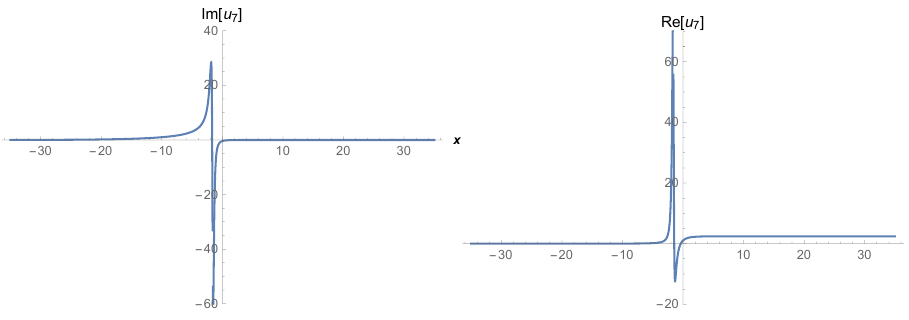
Figure 14. The 2D figures of Equation (20).